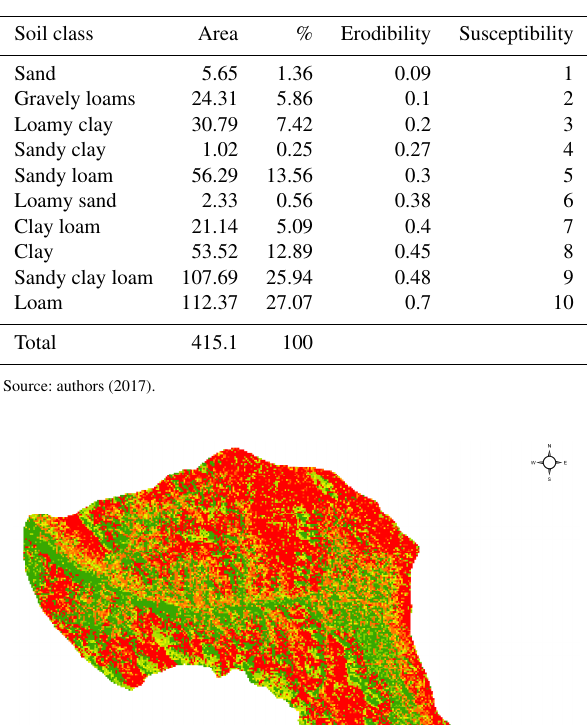
Table 6. Soil classification and erodibility of Orashi.